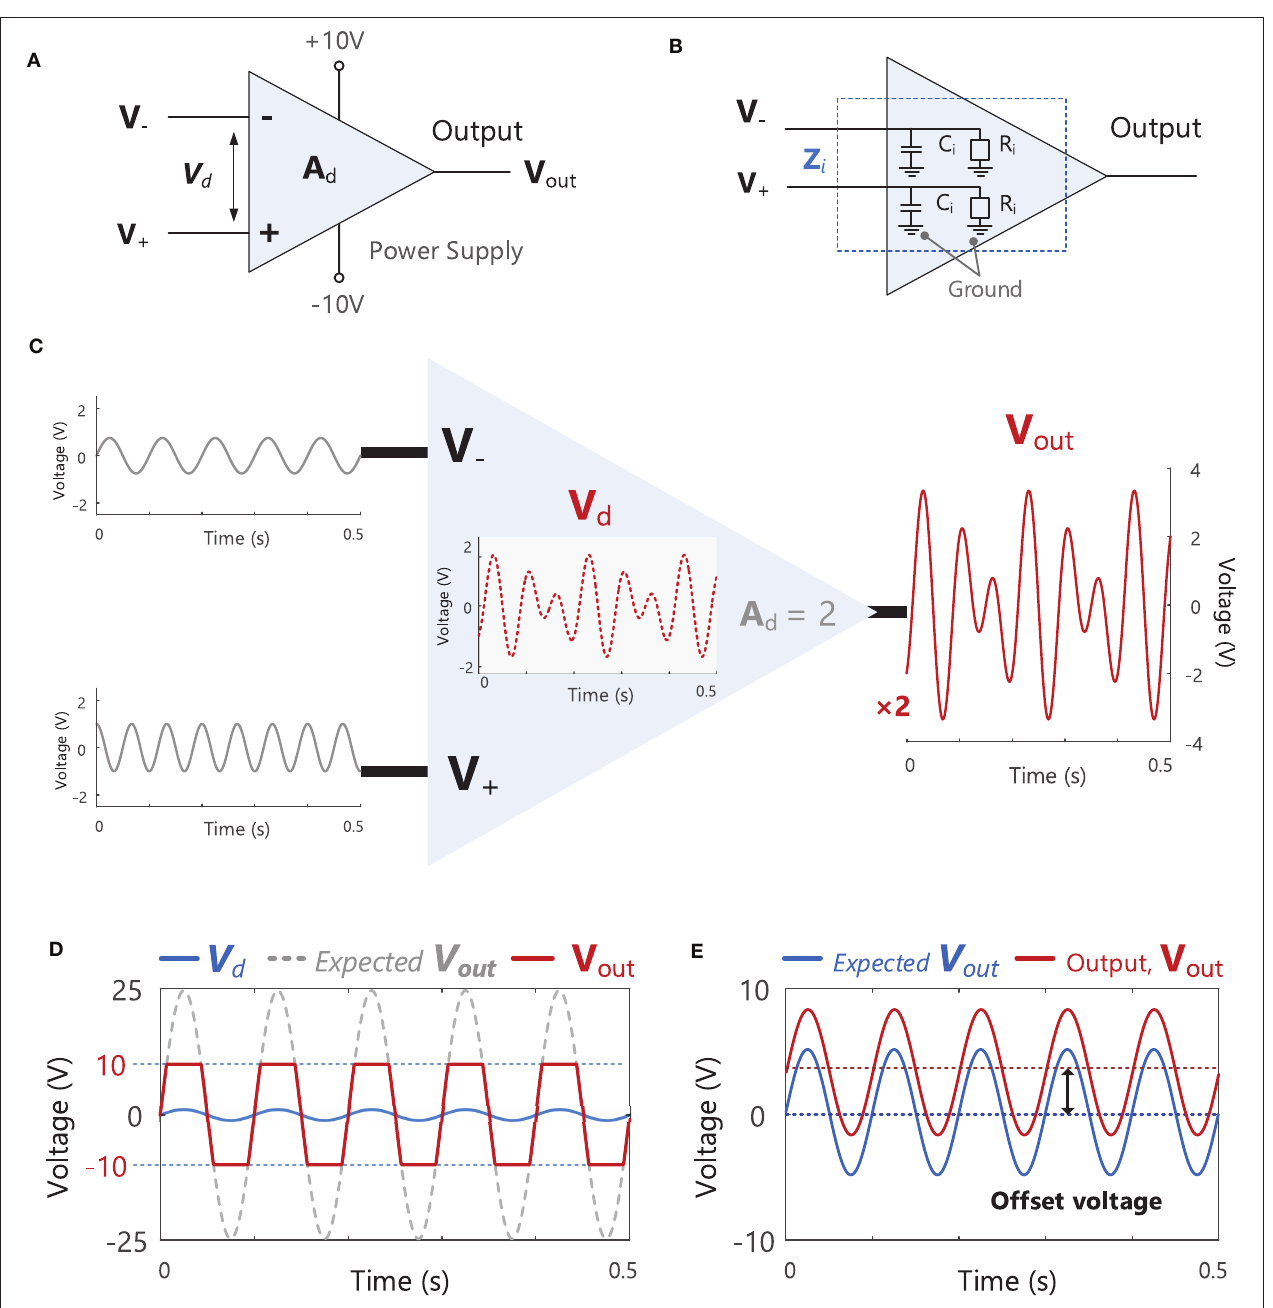
FIGURE 7 | (A) A schematic of an ideal differential amplifier with two inputs V − and V + , an output V out and power supply connections ( + 10 and − 10V). (B) A schematic of the internal input impedance, Z i . present at both amplifier inputs V − and V + . Z i consists of a resistive component, R i , and a capacitive component, C i . (C) A schematic illustration the function of a differential amplifier, which receives two input signals at V − and V + , calculates the difference between these signals, V d (V d = V + - V − ), and multiplies (amplifies) V d by the gain of the amplifier, A d (in this example the signal is increased by a factor of 2). See Example (xii) in Tutorial Code. (D) If the gain of the amplifier is increased to a level where the expected V out exceeds the level of the power supply voltage (e.g., ± 10V in the amplifier shown in A ), the actual V out will be “clipped” or “limited” at the power supply voltage. (E) An example of an offset voltage being present in the amplifier output, V out .